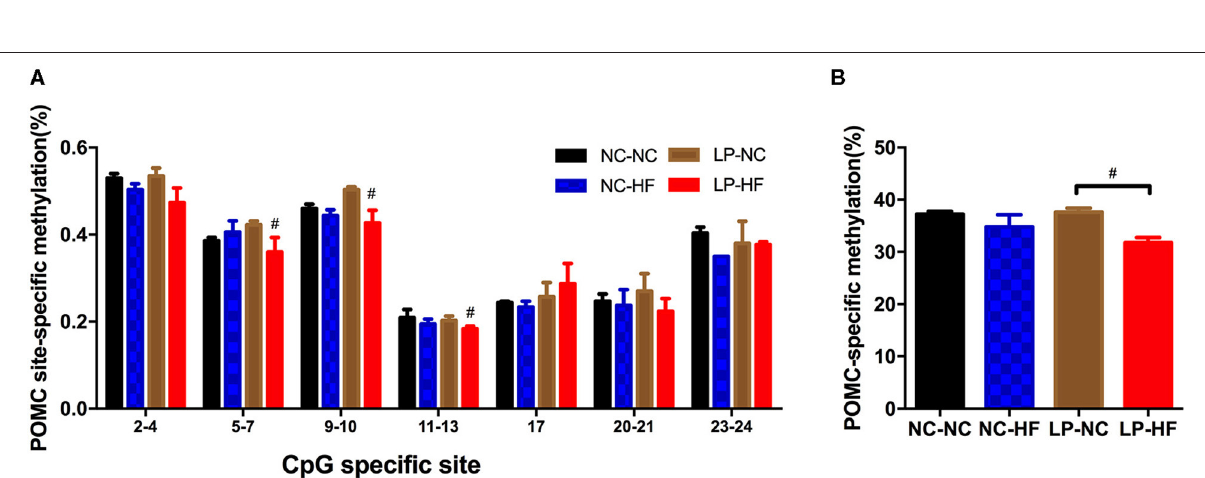
Frontiers in Nutrition |